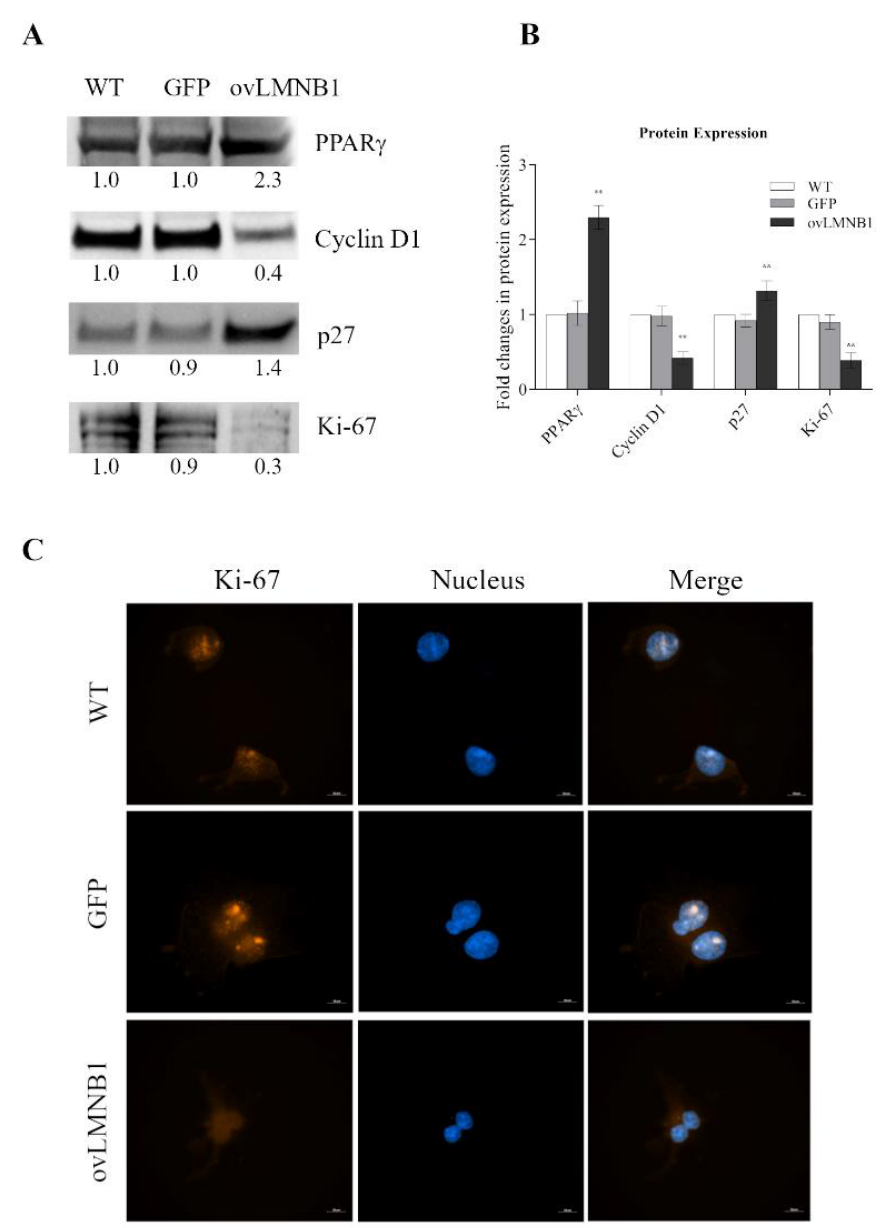
Figure 3. Lamin B1 build up inhibits cell cycle progression and proliferation: The expression of proteins involved in cell cycle progression and apoptosis was evaluated in U87-MG cells 96 h after transduction. Lamin B1 overexpressing cells (ovLMNB1) were compared to wild type (WT) and mock-transduced (GFP) samples. ( A ): Western blot results representative of five independent experiments. The expression of the denoted proteins was assayed. Samples were normalized by performing total protein normalization vs. wild type cells. ( B ): Quantitative analysis of protein expression, wild type cells (WT) were used as reference sample. ** denotes p < 0.01 vs. corresponding mock-transduced sample (GFP). ( C ): Immunofluorescence staining of Ki67 at 63 × magnification (bar: 10 µ M) in wild-type (WT), mock-transduced (GFP), and Lamin B1-overexpressing (ovLMNB1) cells. Nuclei were stained using Hoechst 33342 (blue). The staining of Ki67 is marked in WT and GFP samples, while it becomes faint in cells overexpressing Lamin B1. Results are representative of at least five different